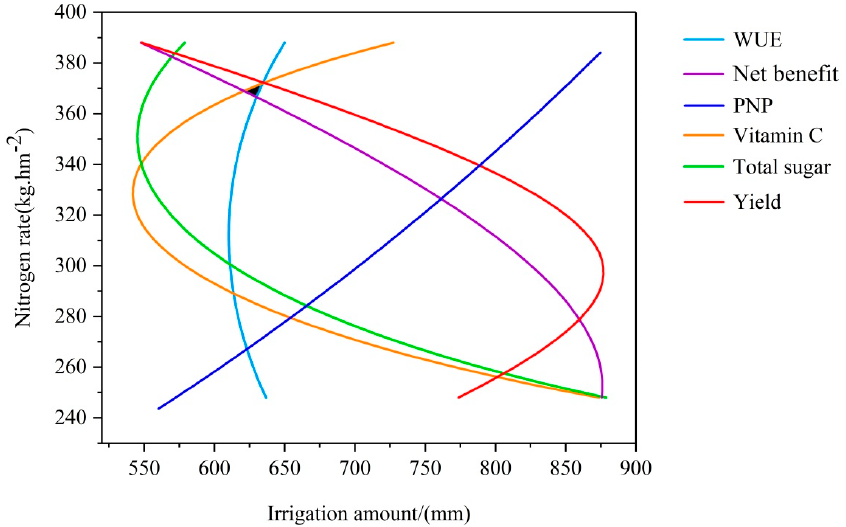
Figure 7. Comprehensive evaluation of yield, economic benefit, vitamin C, total sugar, yield, water use efficiency (WUE), and partial productivity of nitrogen fertilizer (PNP).